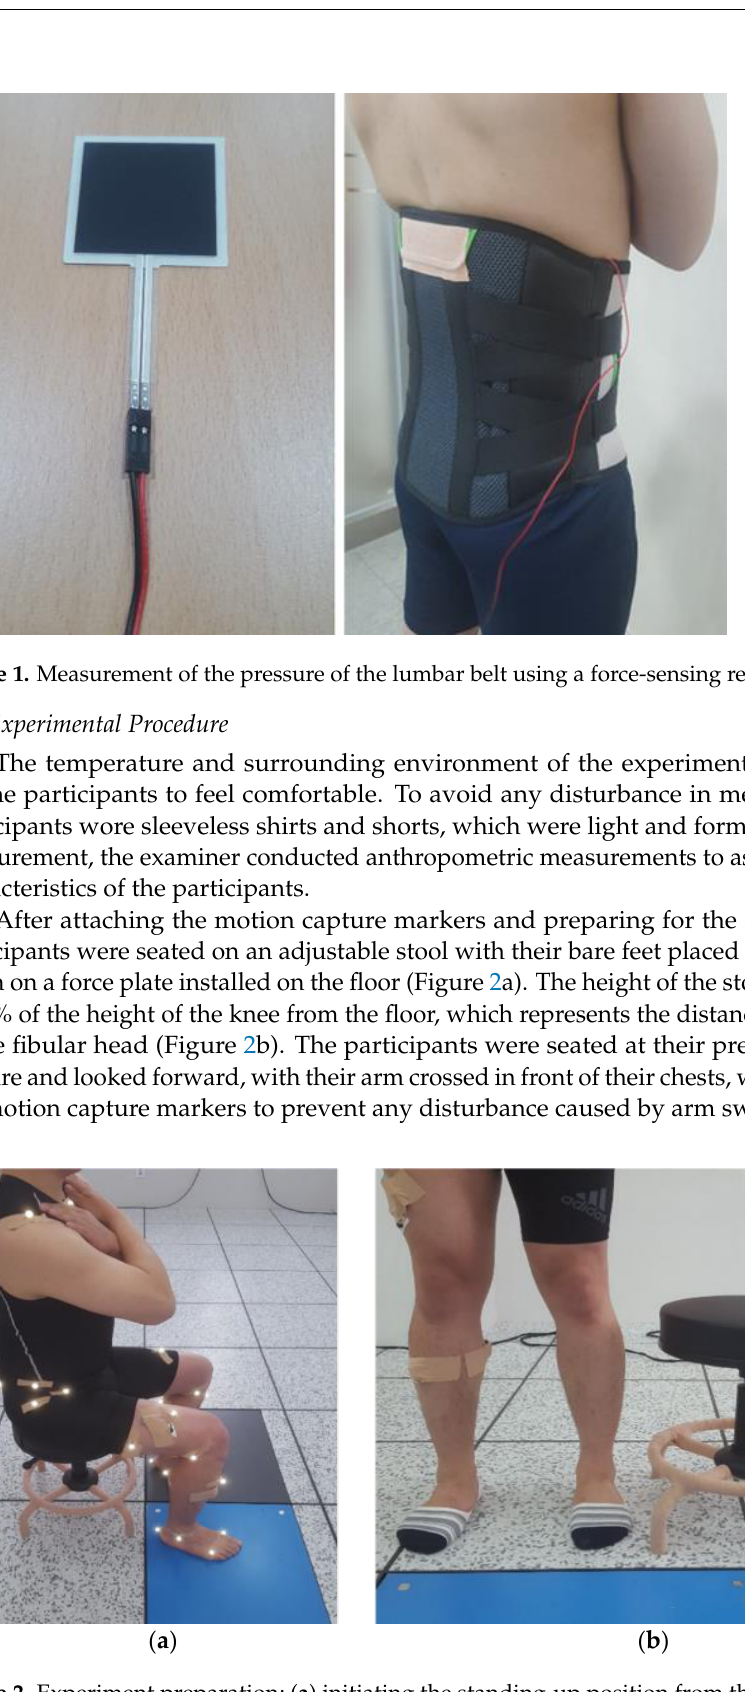
Figure 2. Experiment preparation; ( a ) initiating the standing-up position from the sitting position; ( b ) stool height.